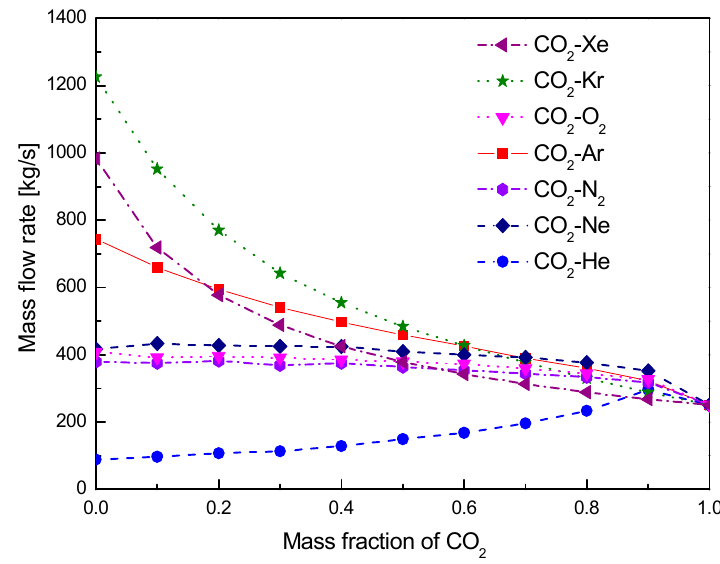
Figure 8. Mass flow rate of mixtures at different mass fractions of CO 2 .